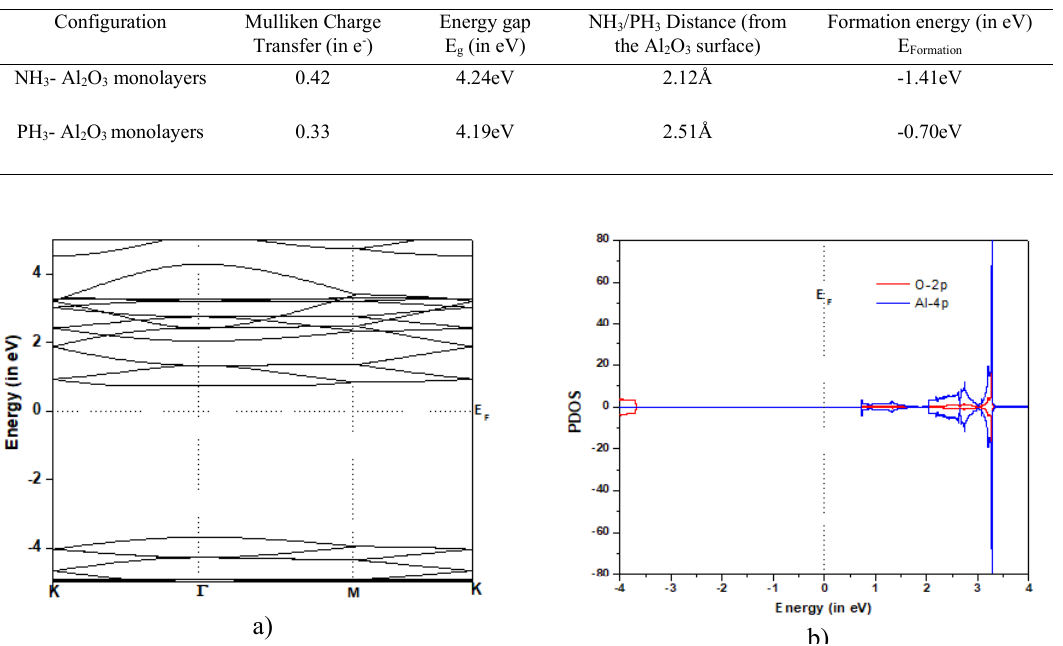
Table. 1. Important parameters for studying the interaction properties of NH